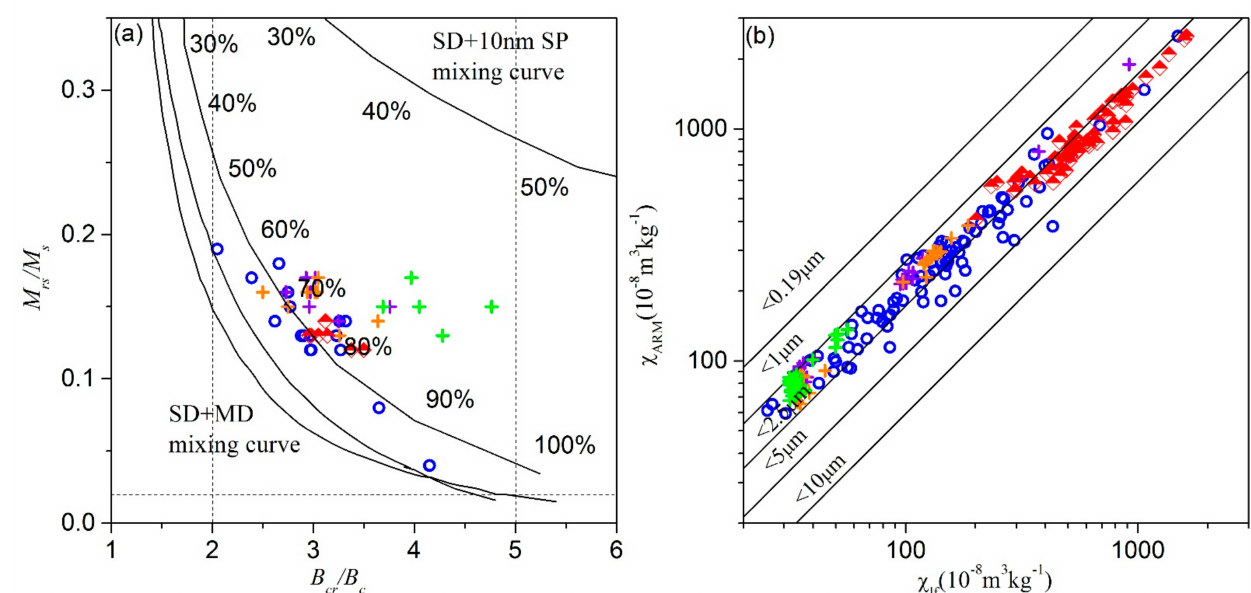
Figure 7. Scatter plots. ( a ) Day plot of the ratios M rs /M s and B cr /B c . Single domain (SD), pseudo-single domain (PSD) and multi-domain (MD) ranges are shown after Dunlop [41]. ( b ) King plot between χ lf and χ ARM [42,43]. The blue hollow circle represents topsoil, the green cross represents soil profile 1, the orange cross represents soil profile 2, the purple cross represents soil profile 3, and the red square represents atmospheric